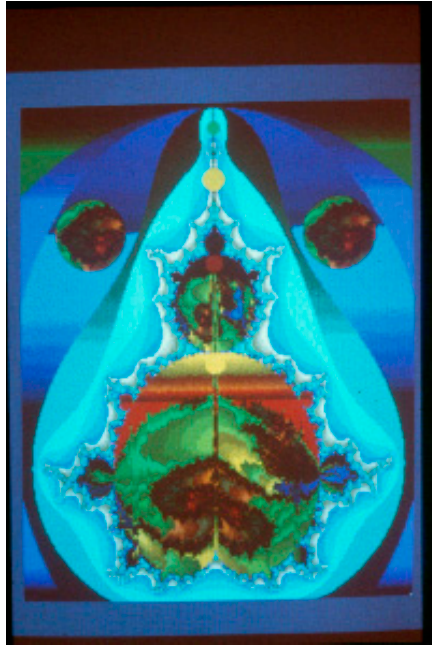
Figure 15. A screenshot which became the artwork “Id”, apparently derived from the Mandelbrot set, manipulated in a paintbox program, and captured on slide film. Published with permission. Image courtesy of the State Library of South Australia. SLSA: PRG 919/22/756.